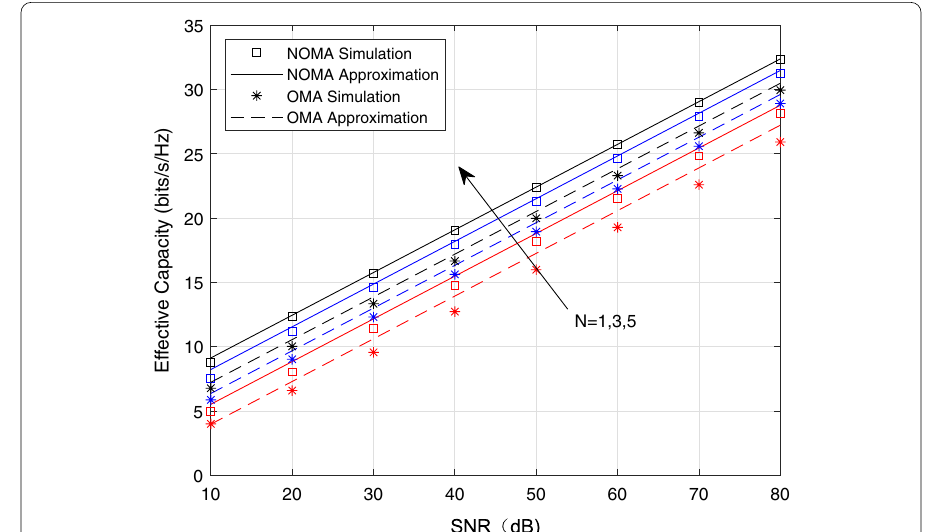
Fig. 5 Comparisons of the sum of EC peformance for NOMA and OMA